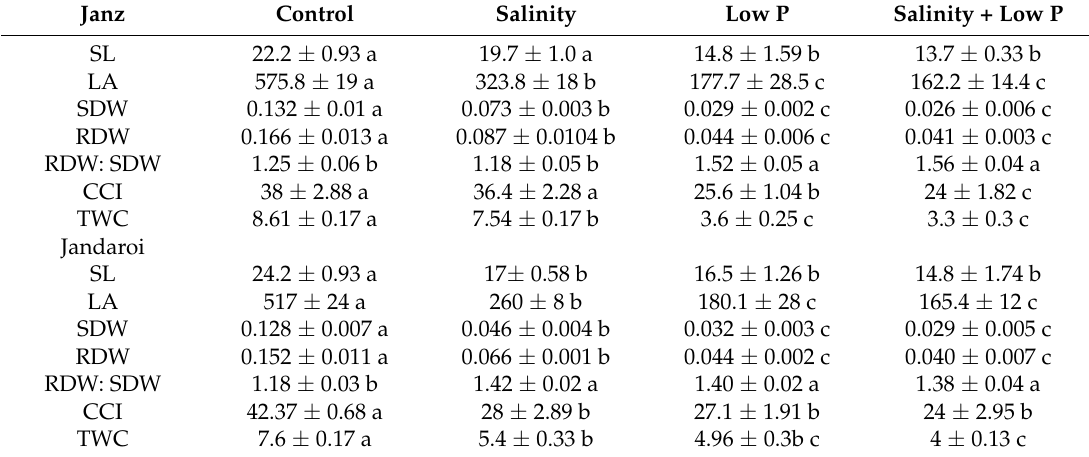
Table 1. Effects of salinity, low phosphorus (P) supply and their interaction on shoot length (SL,